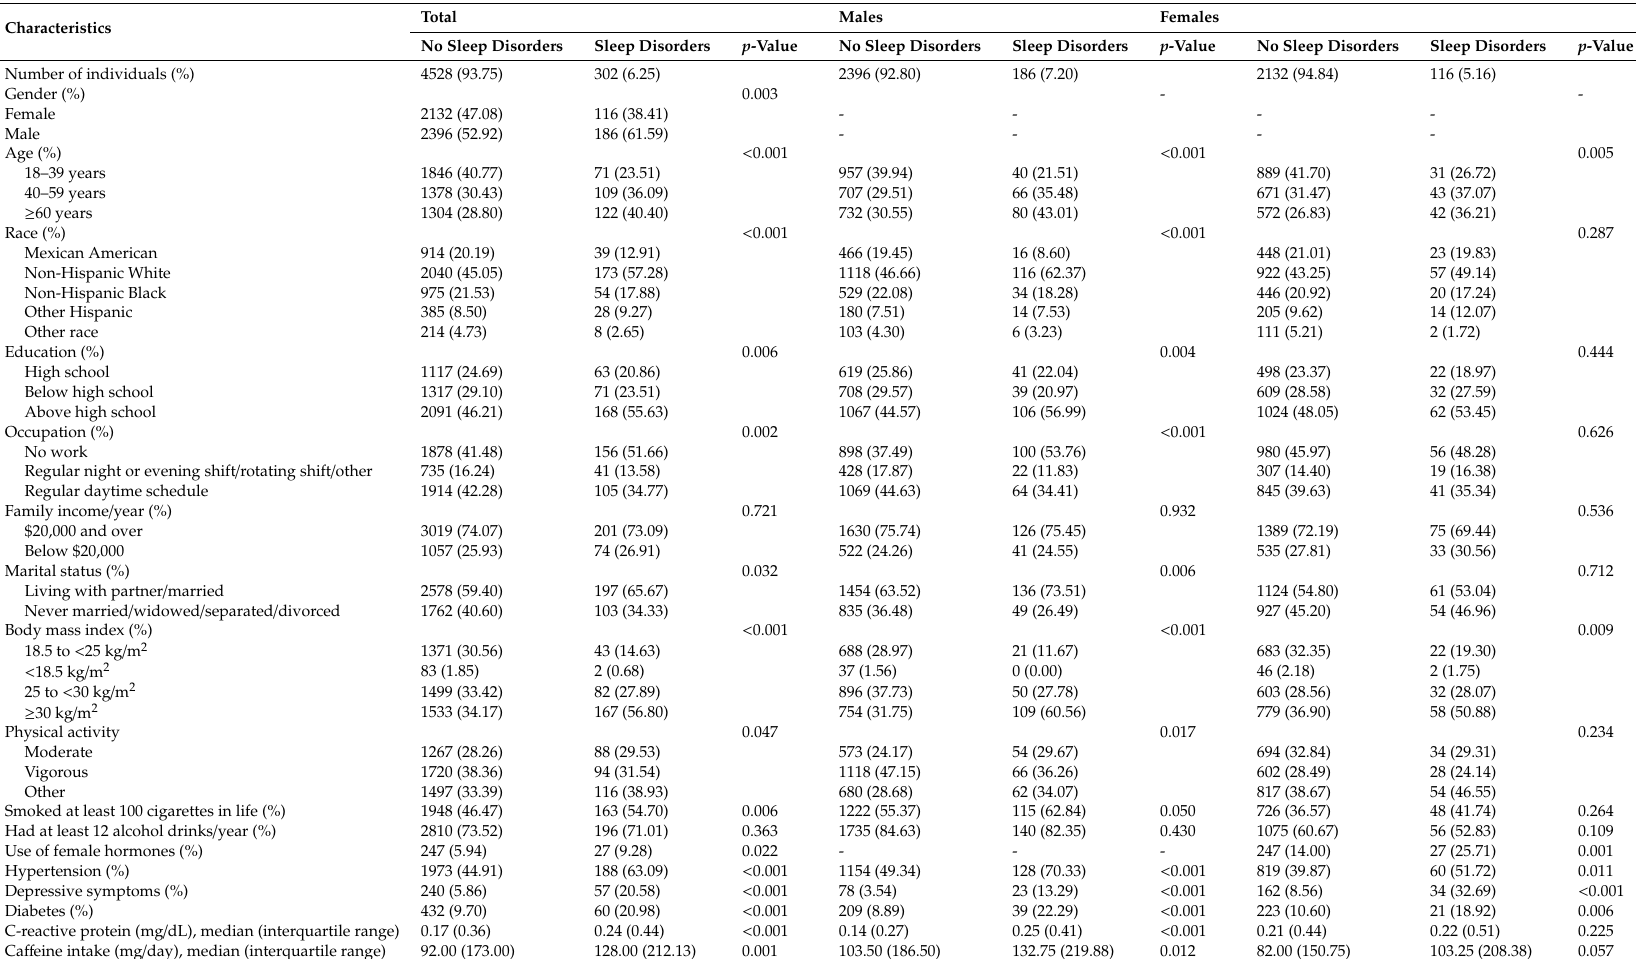
Table 1. Characteristics of the subjects (age ≥ 18 years) by sleep disorders (National Health and Nutrition Examination Survey 2005–2010). Characteristics Number of individuals